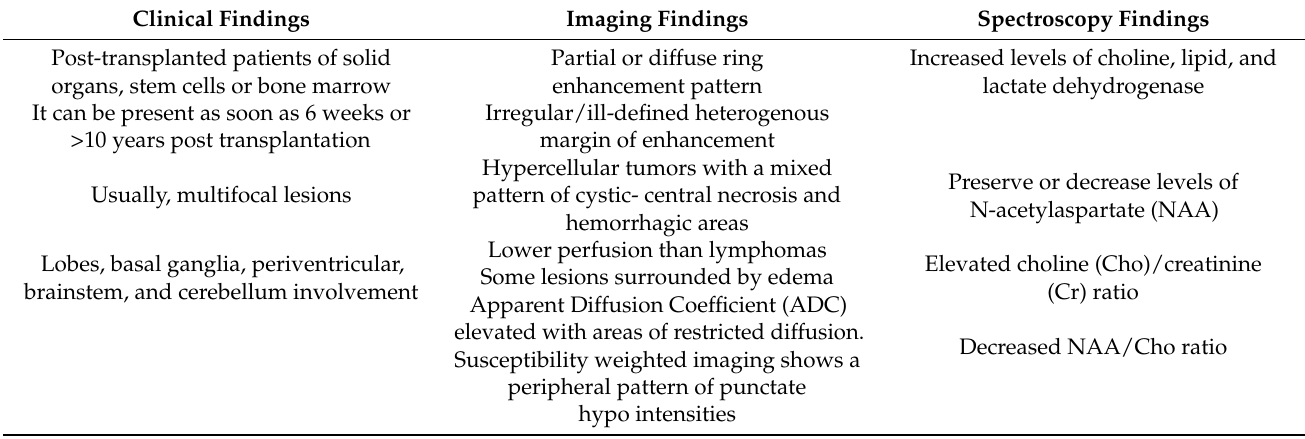
Table 1. Clinical, imaging, and spectroscopy findings of CNS-PTLD [8,10,17,18].